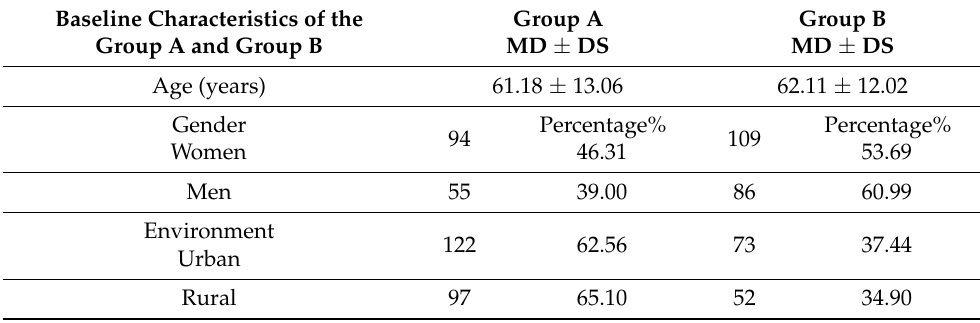
Table 1. Characteristics of the population.